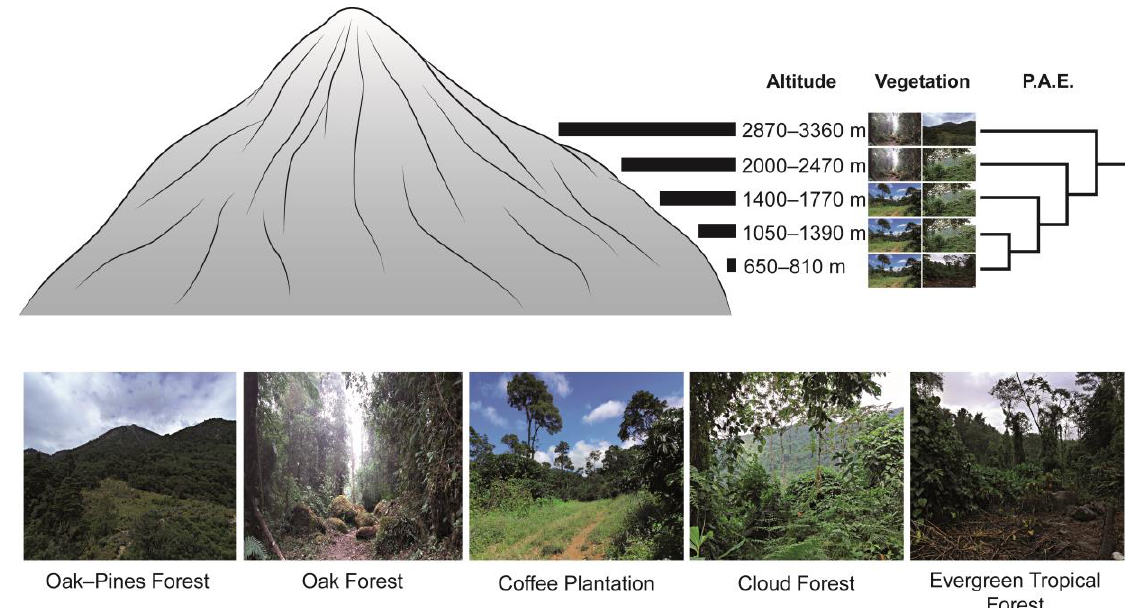
Figure 2. Different altitudinal levels sampled at the Tacan á volcano Biosphere Reserve (Chiapas, Mexico) and its vegetation characterization. PAE = Results of the Parsimony Analysis of Endemism using all Neuroptera species.